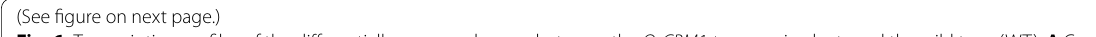
0.05) according to a ≤